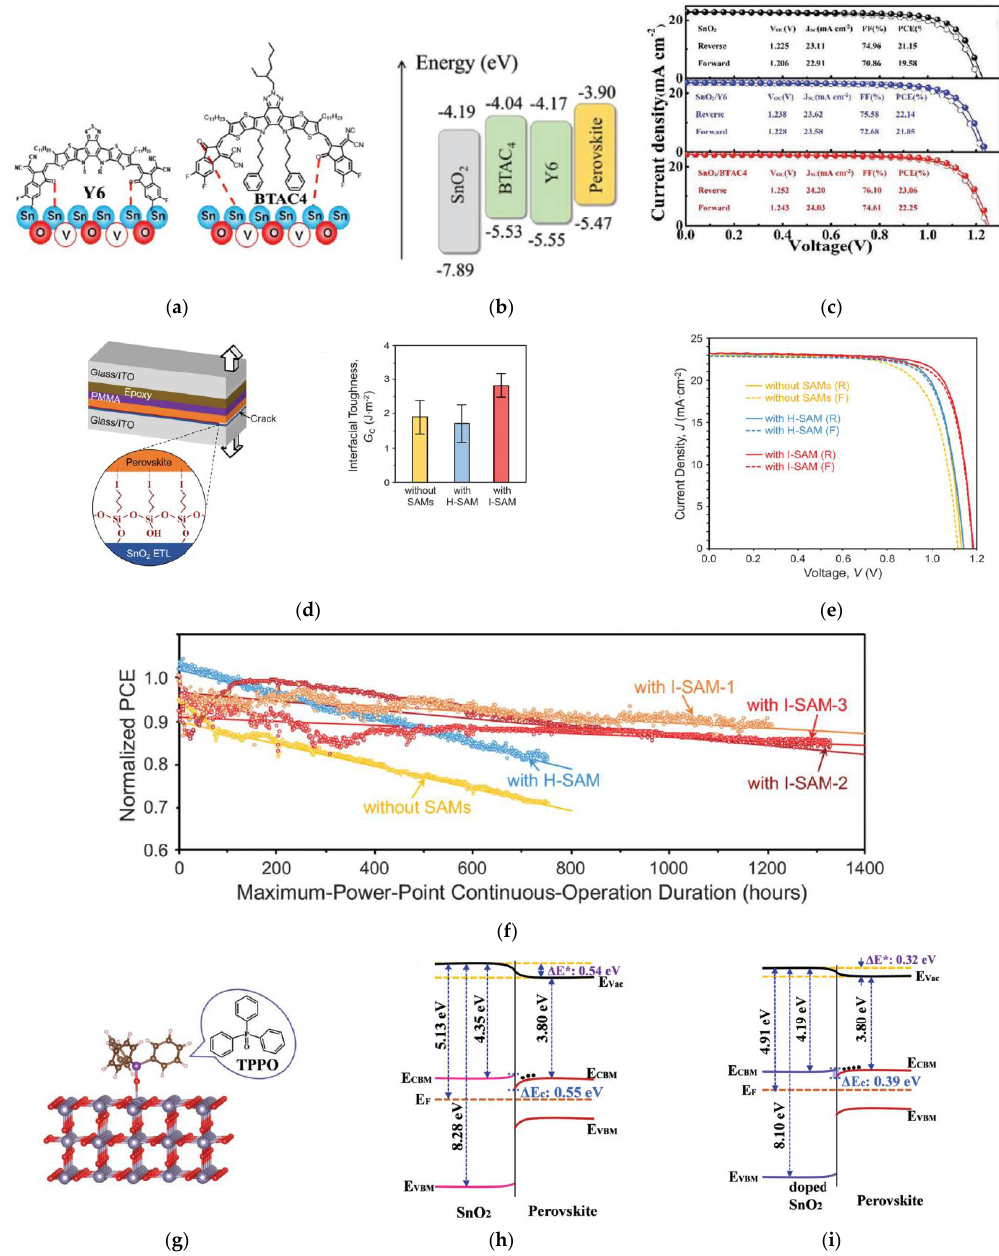
Figure 7. ( a ) Illustration of mechanism of oxygen-vacancy-defect passivation of Y6 and BTAC4. ( b ) Energy-level diagrams of each layer in the PSC. ( c ) Illuminated J - V curves under 1 SUN for reverse and forward scans of SnO 2 , SnO 2 /Y6, and SnO 2 /BTAC4-based devices. Reproduced from [71] with permission from Wiley, 2021. ( d ) Schematic of toughness testing and toughness results with various ETLs. Inset shows illustration of idealized I-SAM. ( e ) Illuminated J - V curves under 1 SUN for reverse and forward scans of SnO 2 , SnO 2 /H-SAM, and SnO 2 /I-SAM based devices. ( f ) Long-term stability measurements of unencapsulated devices with various ETLs at the MPP in N 2 atmosphere under continuous 1 SUN illumination. Reproduced from [72] with permission from American Association for the Advancement of Science (AAAS), 2021. ( g ) The relaxed model of a TPPO molecule absorbed on SnO 2 (110) surface. Energy-level band diagrams of ETL/perovskite heterojunction ( h ) without and ( i ) with TPPO-surface treatment of SnO 2 . Reproduced from [73] with permission from Wiley,